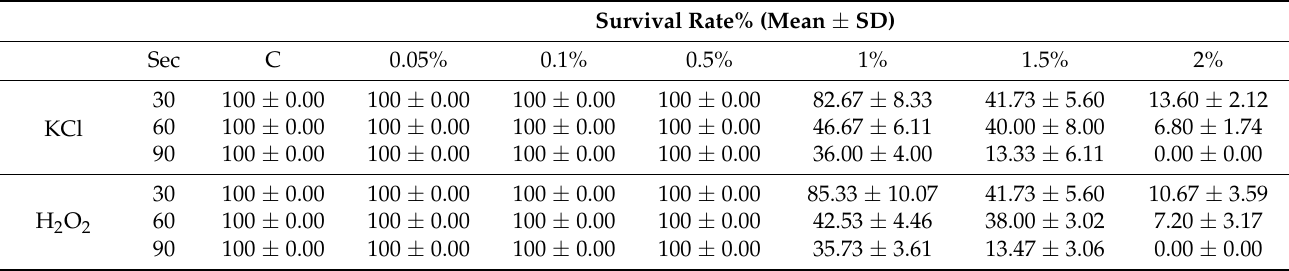
Table 2. Inhibitory concentrations of KCl and H 2 O 2 on